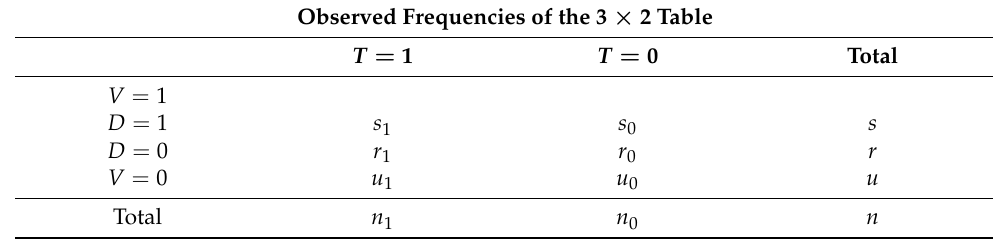
Table 2. Observed frequencies in the presence of partial verification. Observed Frequencies of the 3 × 2